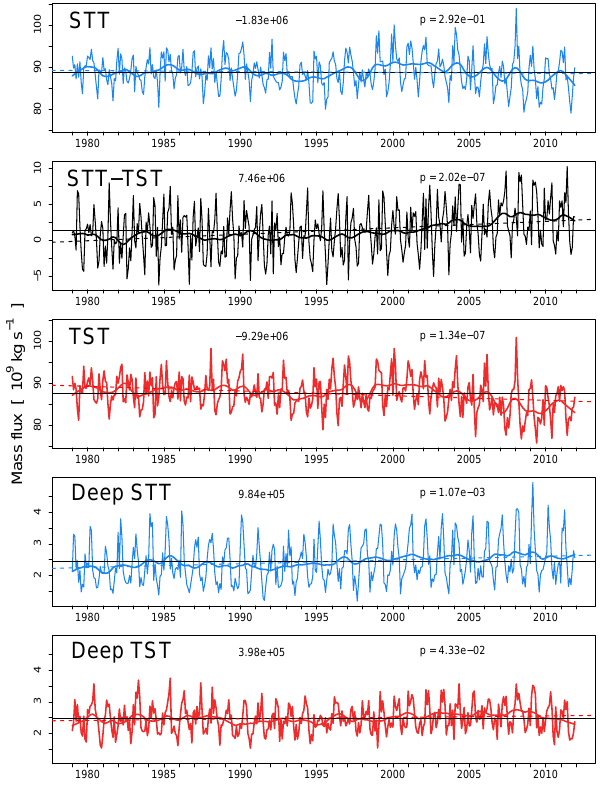
Fig. 12. Time series of globally integrated STT, net (STT–TST), TST, deep STT, and deep TST mass fluxes (monthly averages) from 1979 to 2011. The bold line is a 12-month moving average, the thin horizontal line (solid) is the mean value of the 33yr, and the thin sloping line (dashed) is the fit from a linear regression over the whole period. The trends (top middle) inkgs − 1 month − 1 and p val- ues (top right) are shown within the individual